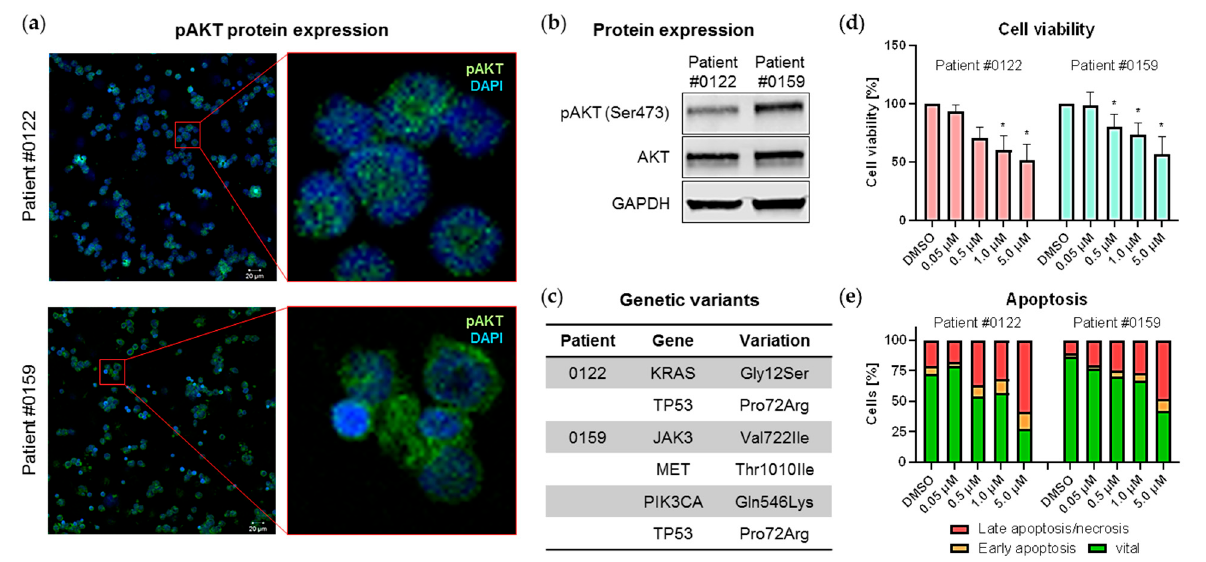
Figure 4. Effects of MK-2206 on primary B-ALL blasts. ( a,b ) Protein expression of phosphorylated and total AKT was measured by immunofluorescence staining ( a ) and immunoblotting ( b ). Cells of patients #0122 and #0159 were orthotopically xenografted into NSG mice as described in [33,34] and spleen cells were subsequently harvested for further analysis. ( a ) Expression of pAKT was determined by immunofluorescence using the LSM780 confocal microscope (Zeiss) at 20-fold magnification (left panel). The right hand images are enlargements of the regions indicated in the left hand red boxes. ( b ) Cells were lysed and analyzed for phosphorylated and total AKT protein expression by immunoblot. GAPDH was used as internal loading control. Blots were processed and cropped using Image Studio Lite 5.2 software and MS PowerPoint (2011) to improve clarity and conciseness. ( c ) Genetic variants in both patients were detected using Cancer hotspot panel (Ion PGM System, Thermo Fisher Scientific) and previously described in [34]. ( d,e ) Xenograft-derived primary blasts were cultured on a murine stromal cell feeder layer system and cell viability and apoptosis induction were assessed after 72 h incubation with increasing concentrations of MK-2206. ( d ) Cell viability was determined by CellTiter Blue assay in technical triplicates. Mean ± standard deviation of three individual biological replicates. Significance was determined by student’s t test after testing Gaussian distribution. * P < 0.05. ( e ) Cells were stained with anti-human CD19, annexin V-FITC and PI for apoptosis analysis by flow cytometry. Cells positive for annexin V and negative for PI are indicated as early apoptotic whereas cells positive for both markers are considered late apoptotic/necrotic. Human primary blasts and murine feeder cells were discriminated by anti-human CD19 staining.